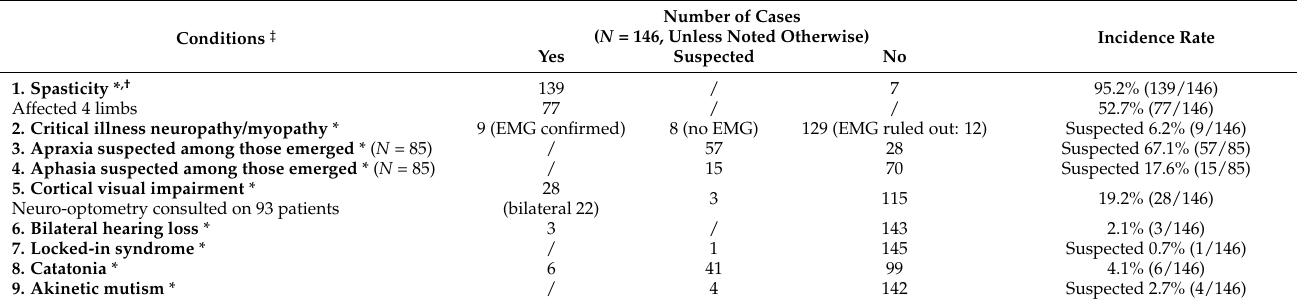
Table 3. Common neurologic complications and comorbidities that can be confounders or mimics of